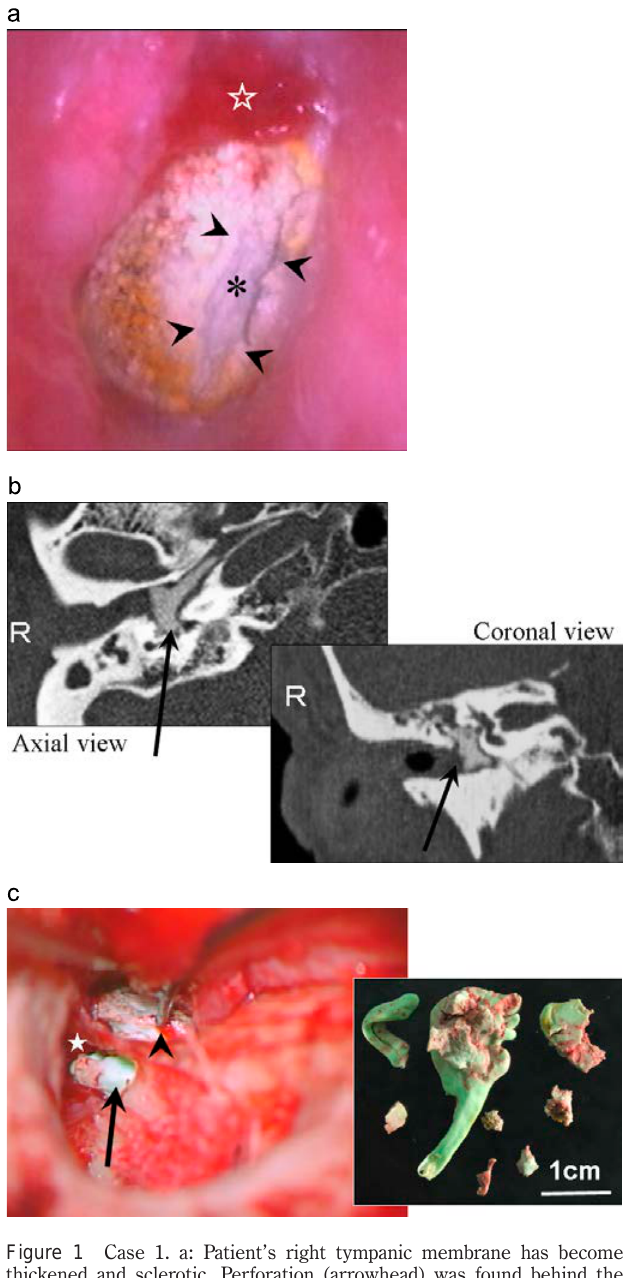
Figure 1 Case 1. a: Patient’s right tympanic membrane has become thickened and sclerotic. Perforation (arrowhead) was found behind the tympanic membrane. A calcified and indurated plate-like substance (asterisk) was identified in the tympanic cavity. Granulomas (star) were seen in the epitympanum. Purulent otorrhea has accumulated. b: Dorsal view after mastoidectomy. Computed tomography (CT) shows the temporal bone without contrast. Note the uniformly high-density area (arrow) in the tympanic cavity. c: Perioperative findings and foreign bodies. The incus (star) and chorda tympani n. (arrowhead) are seen. The light green foreign body (arrow) occupied the space between the tympanic cavity and mastoid antrum. Right: The foreign bodies have been removed from the middle